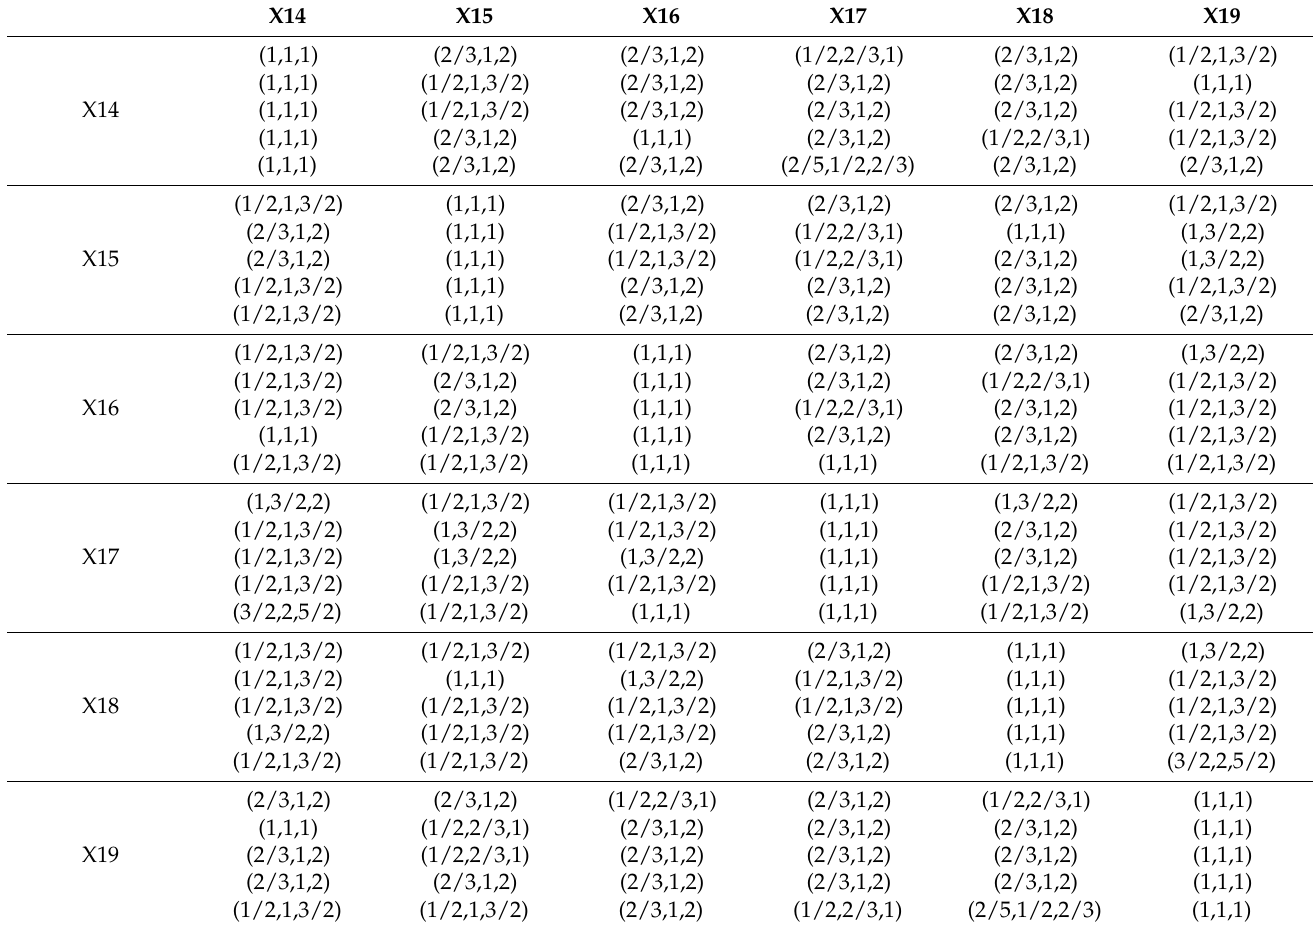
Table A4. Pairwise comparison of the elements in the category of ‘Environmental